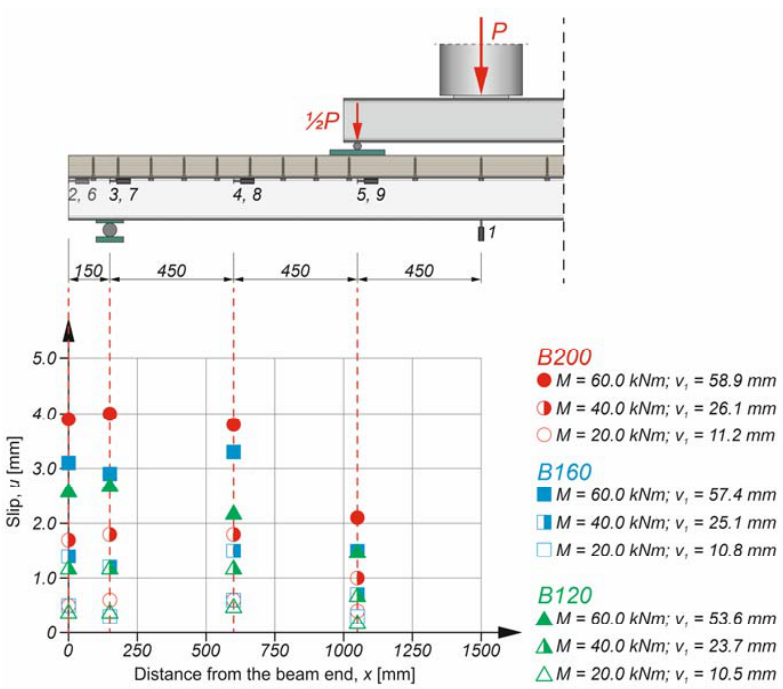
Figure 11. The comparison of the mean values of the slip in the analysed beams.